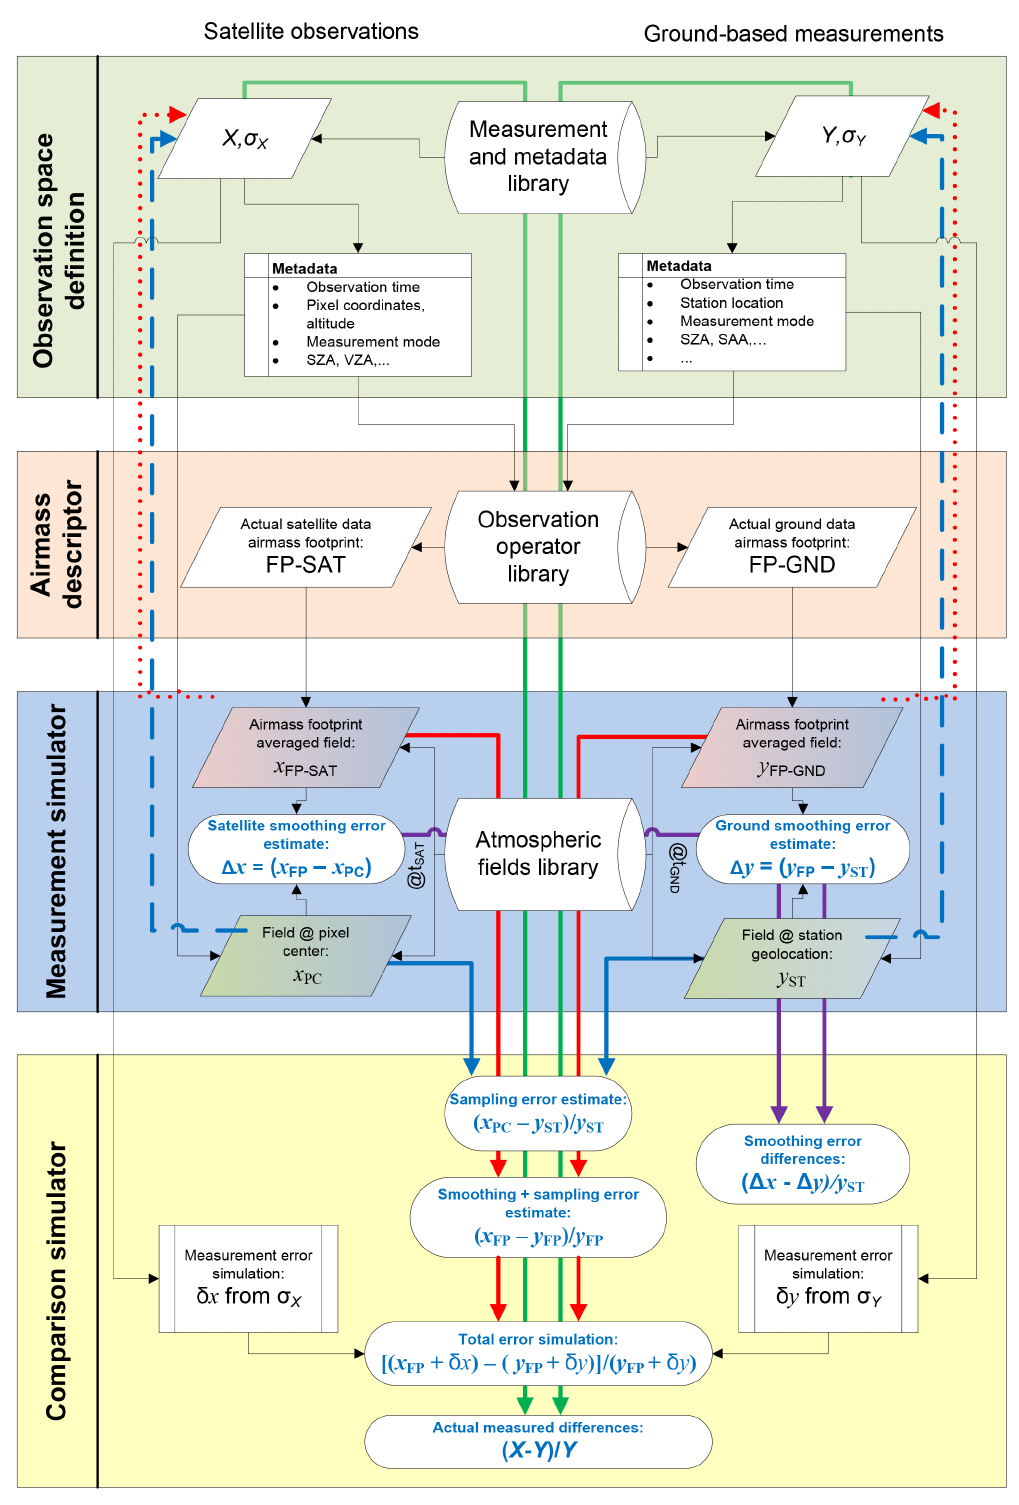
Figure 2. Architecture of the OSSSMOSE atmospheric metrology simulator as set up for the error budget closure of ground-based satellite validations. X and Y refer to the actual observations, e.g. hereafter total ozone data retrieved from GOME-2A and Brewer measurements, while x and y with varying subscripts refer to the simulated observations. The lateral feedback loops – highlighted in dashed blue and dotted red – show the possibility to compare the simulated observations to the real